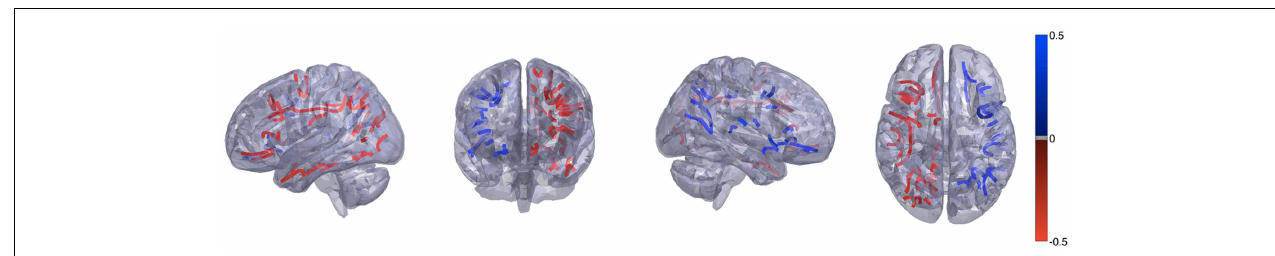
FIGURE 3 |Anatomical demonstration of the location of links with an absolute asymmetry index greater than 0.5 . Links in red exhibit a leftward asymmetry, while links in blue demonstrate a rightward